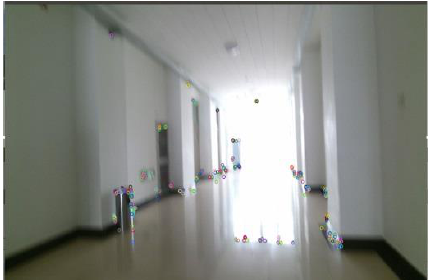
Fig. 1. Flowchart of our proposed visual SLAM